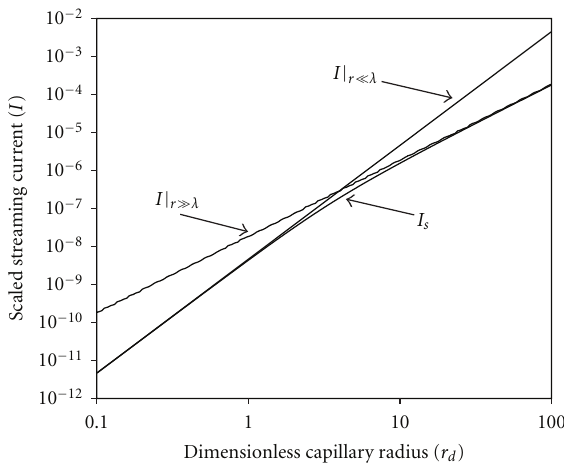
Figure 4: Typical results showing streaming current calculated using (i) the Poisson-Boltzmann equation ( I s ), (ii) assuming a thin double layer ( I | λ (cid:4) r ), and (iii) assuming a thick double layer ( I | λ (cid:3) r ), as a function of dimensionless capillary radius ( r d ). The reported streaming currents have been scaled to the value of I | λ (cid:3) r at r d = 1000. Note that there is a value of r d for which I | λ (cid:3) r = I | λ (cid:3) r . At this value of r d , the dimensionless streaming current I d is undefined (20).